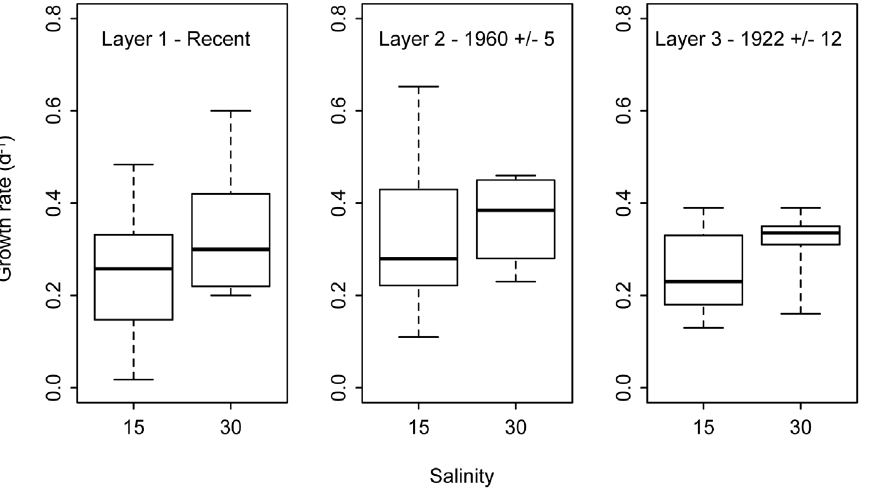
Figure 2. Growth performance of Pentapharsodinium dalei strains according to sediment core layer and salinity level. Boxplots show range (whiskers), median (bold line), and interquartile range (box height) for growth rates at salinity 15 and 30 for the three sediment core